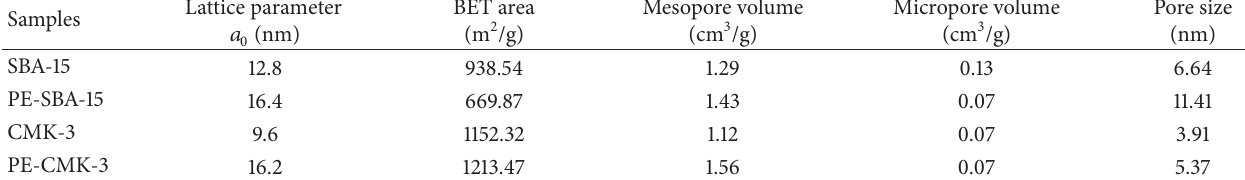
Table 1: The samples texture properties.